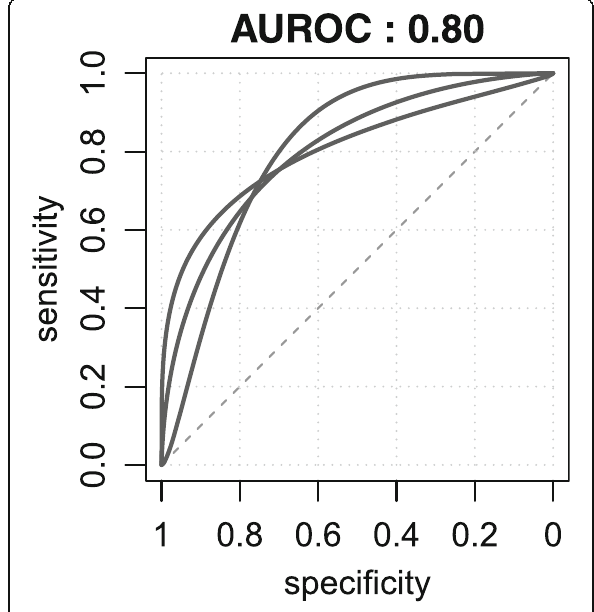
Fig. 1 Three different receiving operating curves with the same AUROC